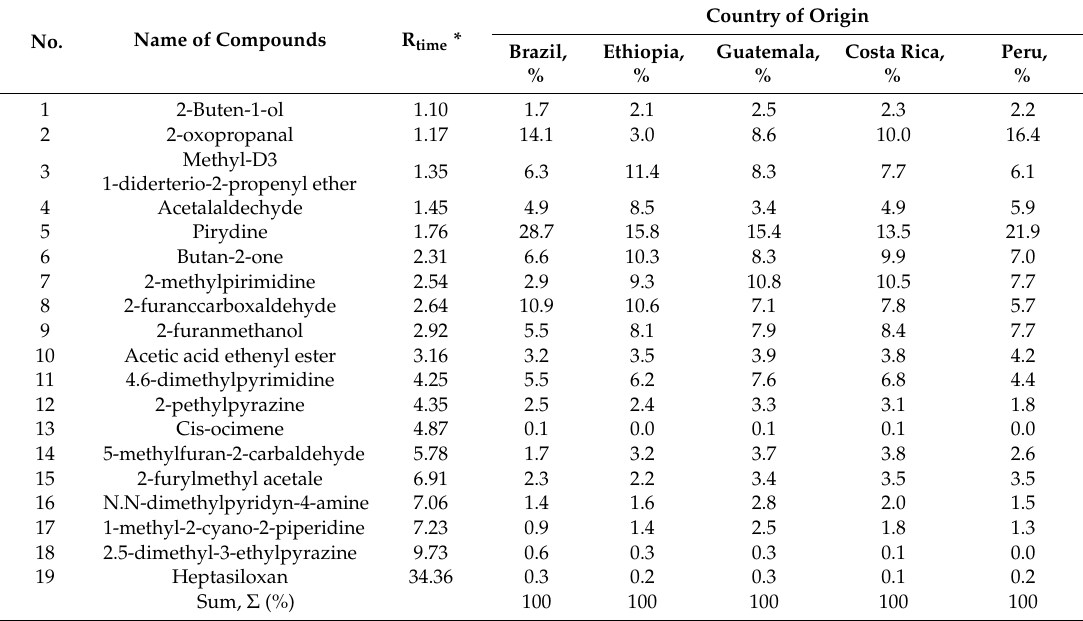
Table 1. Chemical compounds detected in all Arabica co ff ees from: Brazil, Ethiopia, Guatemala, Costa Rica, and